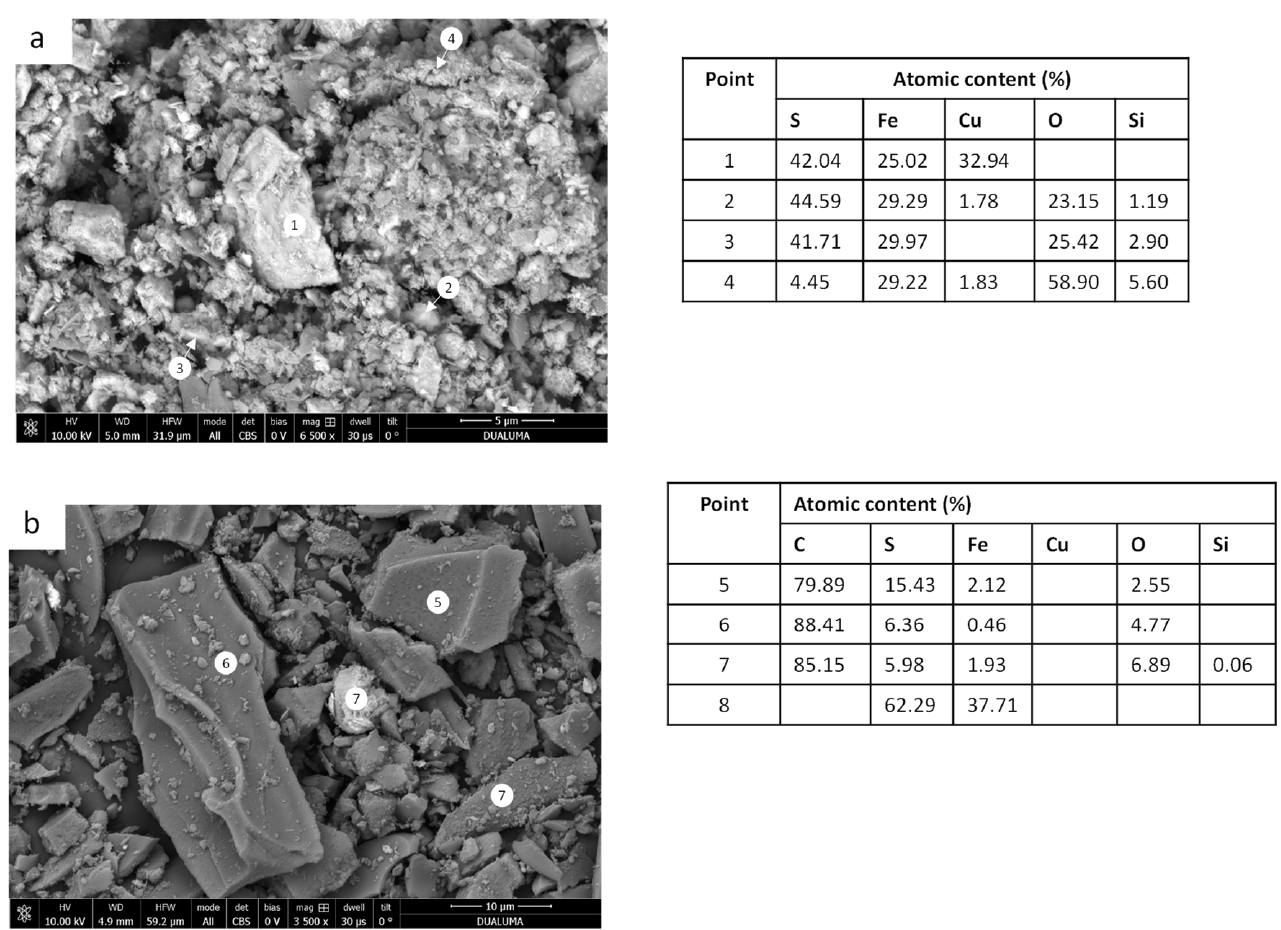
Table 4. XRD analysis of final solid residues after leaching